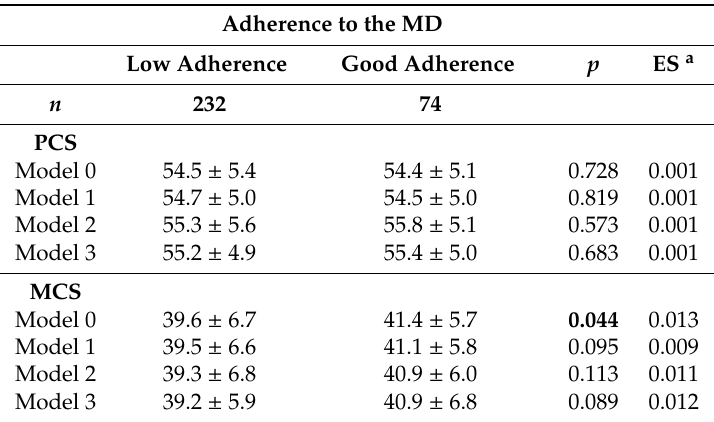
Table 4. ANCOVA models comparing the means of physical HRQoL(PCS) and mental HRQoL(MCS) with the Mediterranean Diet Adherence Screener (MEDAS-14) items categories after controlling for cardiorespiratory fitness (CRF) and handgrip strength. Adherence to the